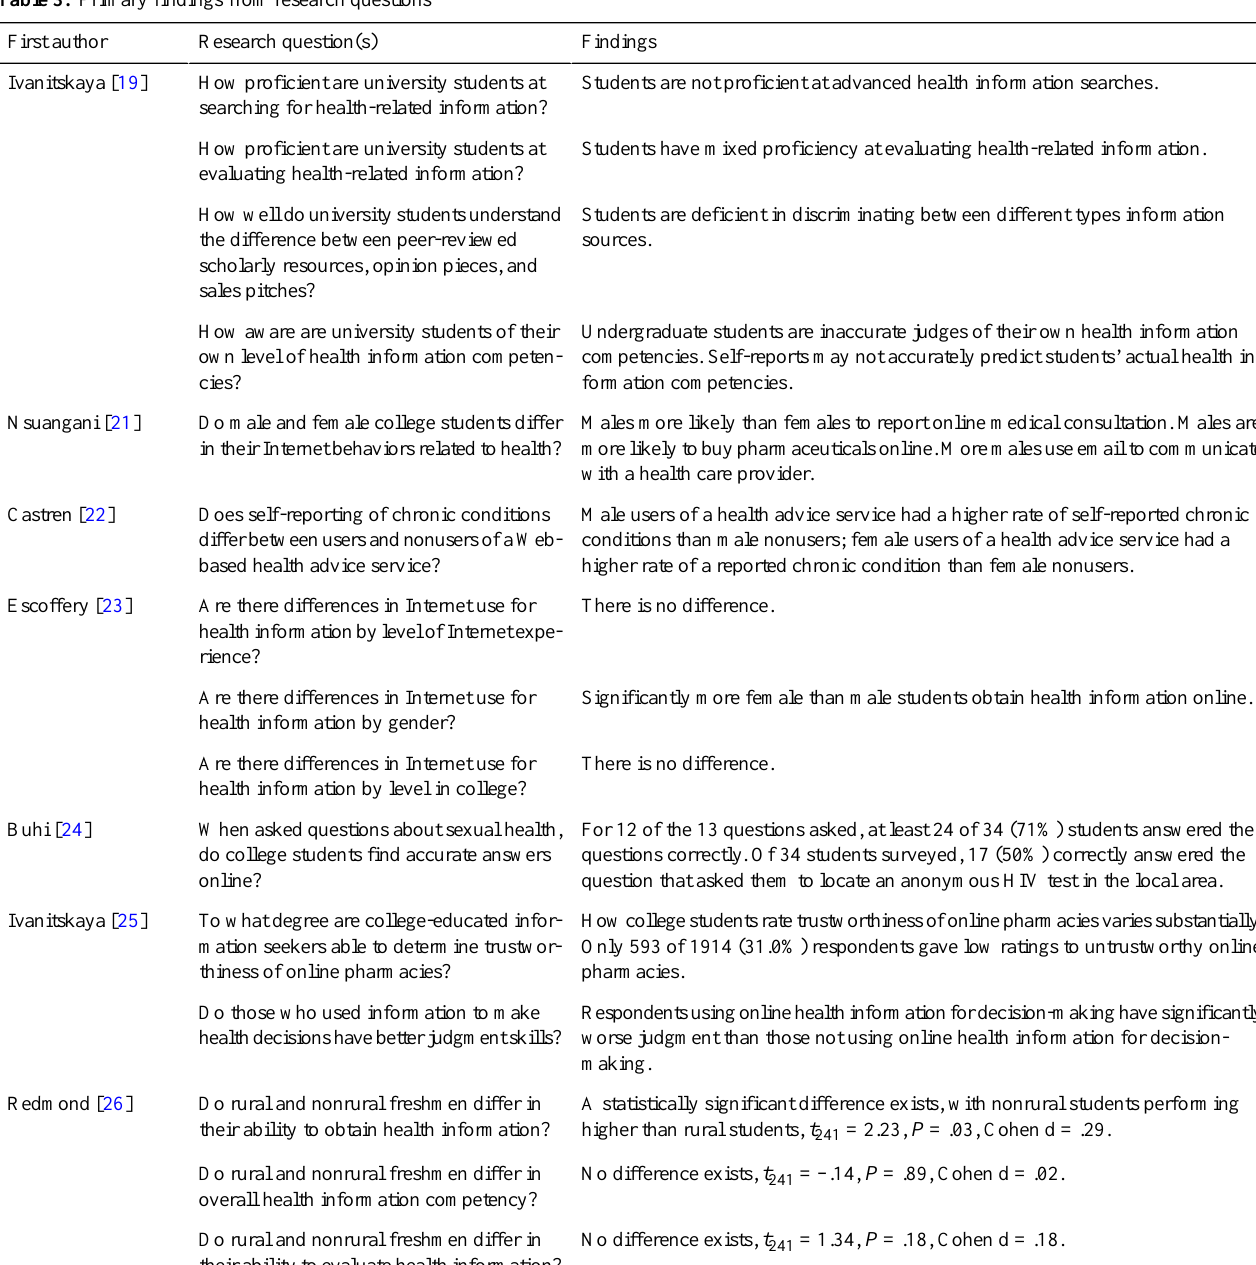
Table 3. Primary findings from research questions